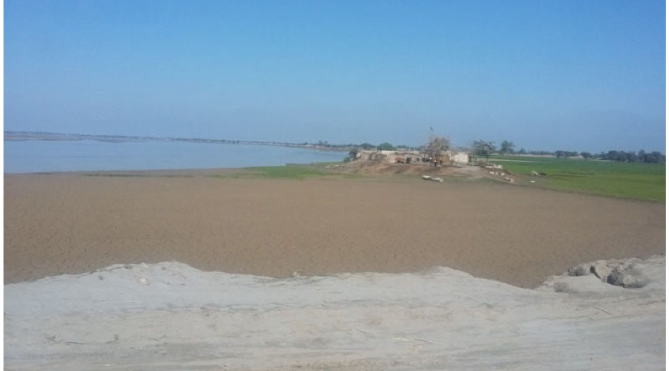
Figure 10. People living with the highest risk of soil erosion in River Indus, district Layyah.